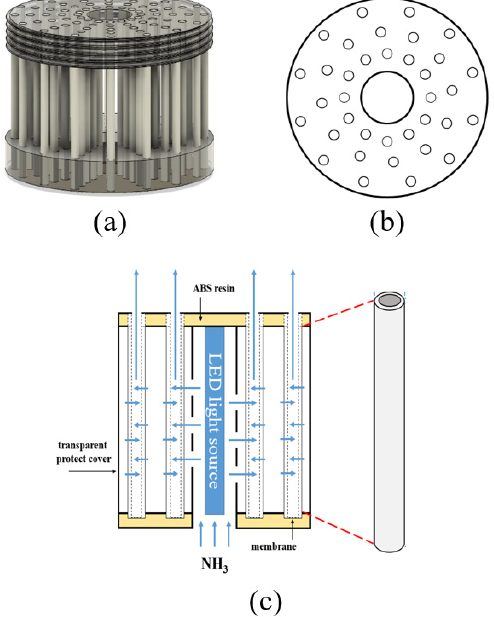
Figure 1. ( a ) Schematic diagram of the photocatalytic filter-type module with ( b ) 36 membranes. ( c